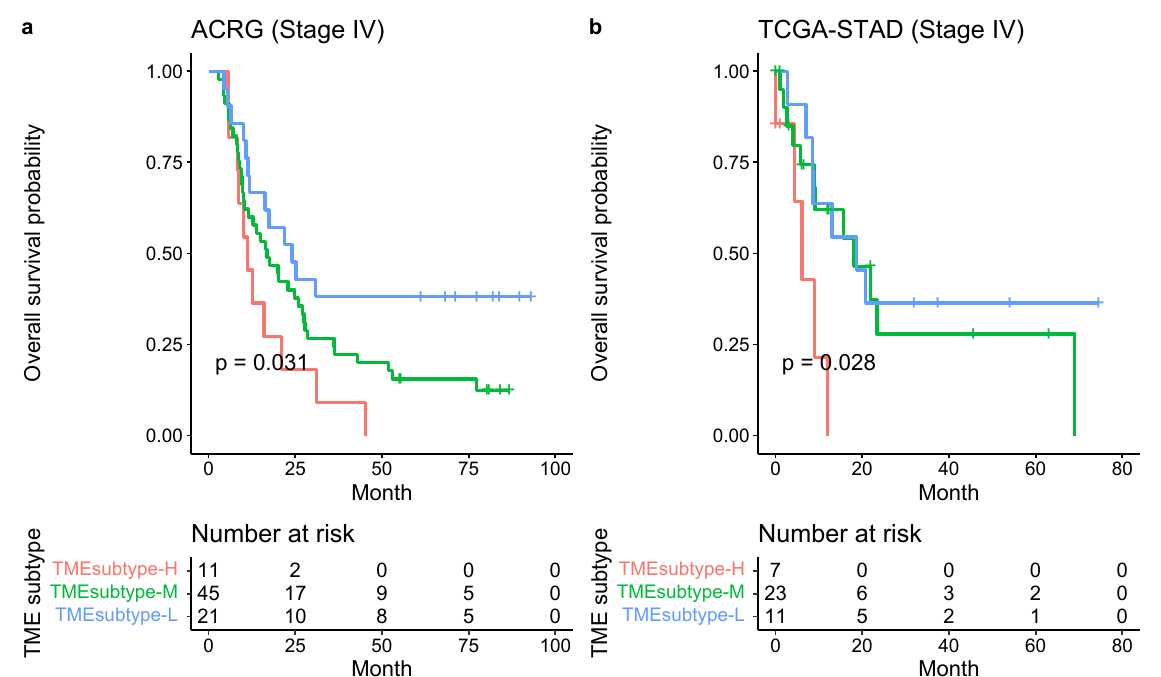
Figure 18. TME subtype in patients with stage IV GC. Kaplan–Meier plots for the OS of patients with stage IV GC stratified into three TME subtypes in the ACRG ( a ) and TCGA-STAD ( b ) cohorts.